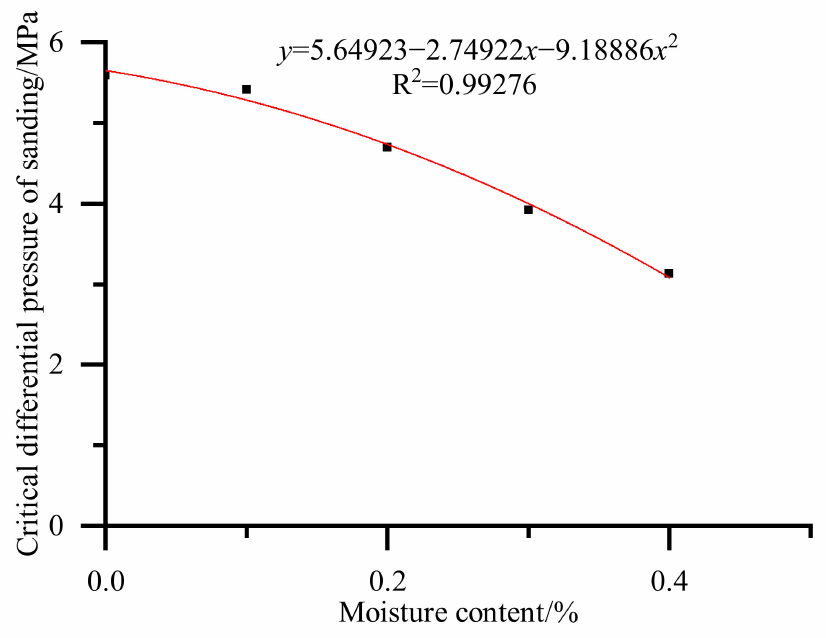
Figure 13. Critical differential pressure of gas production for different moisture